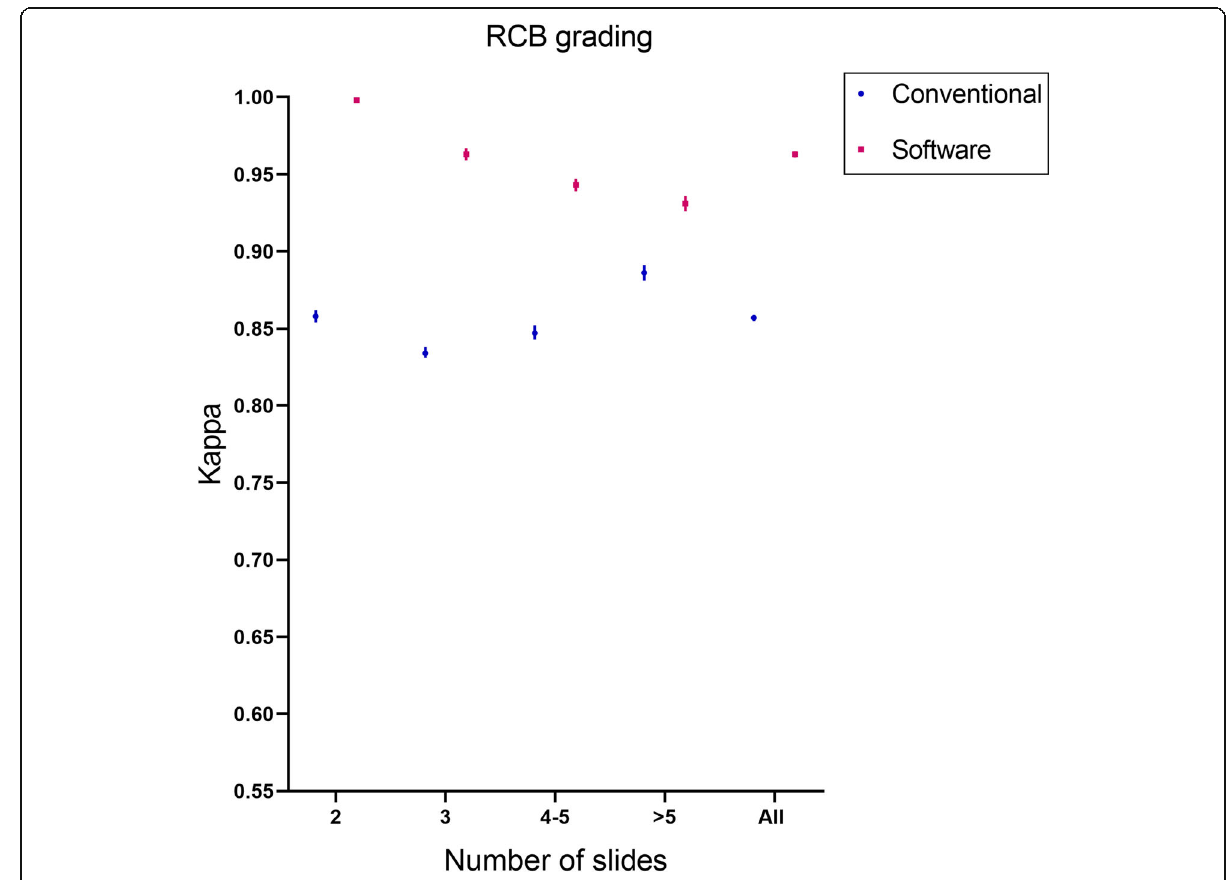
Fig. 8 Comparison of RCB grading consistency between the software-assisted method and conventional method by five